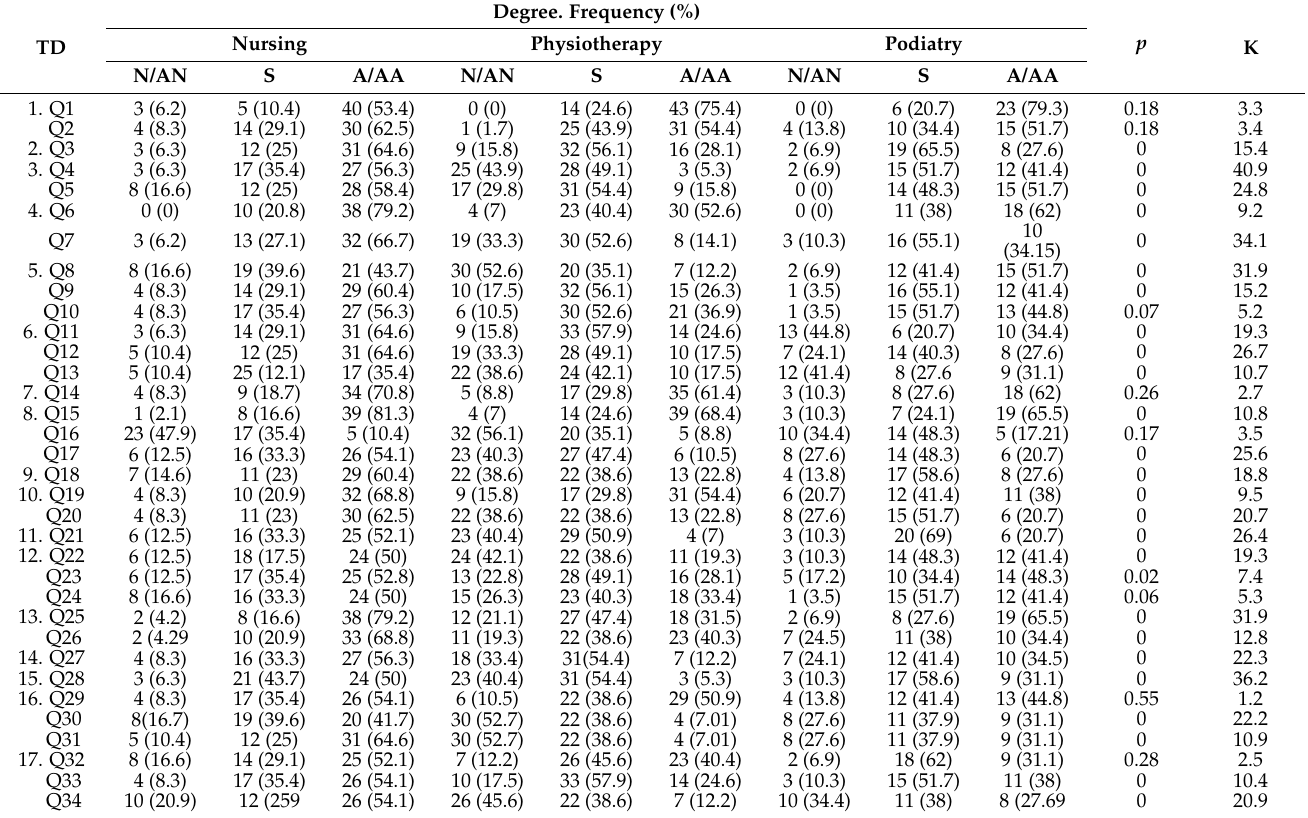
Table 3. Results obtained in each degree according to the teaching dimension. p -value. Kruskal–Wallis